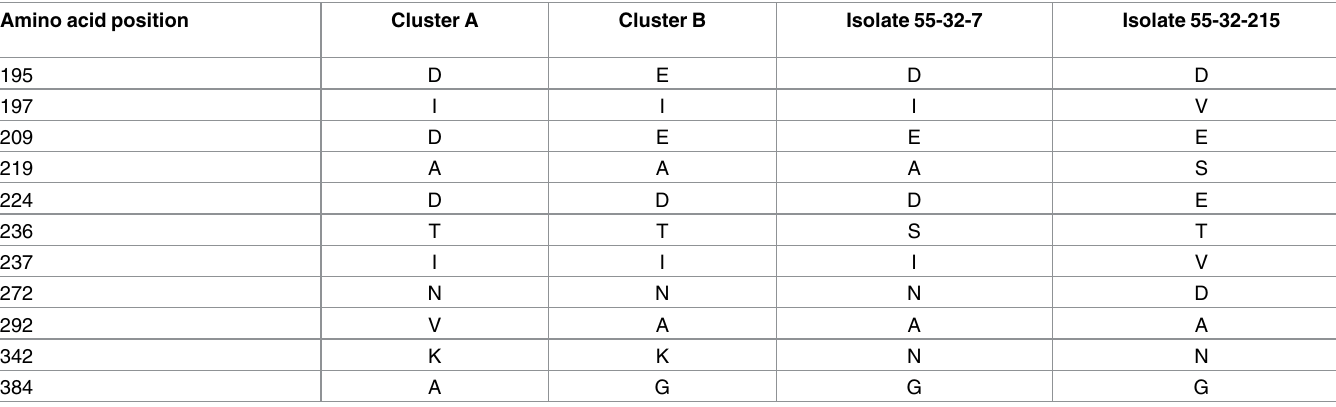
Table 4. Amino acid alterations in EFG-G of methicillin-resistant Staphylococcus sciuri . Amino acid